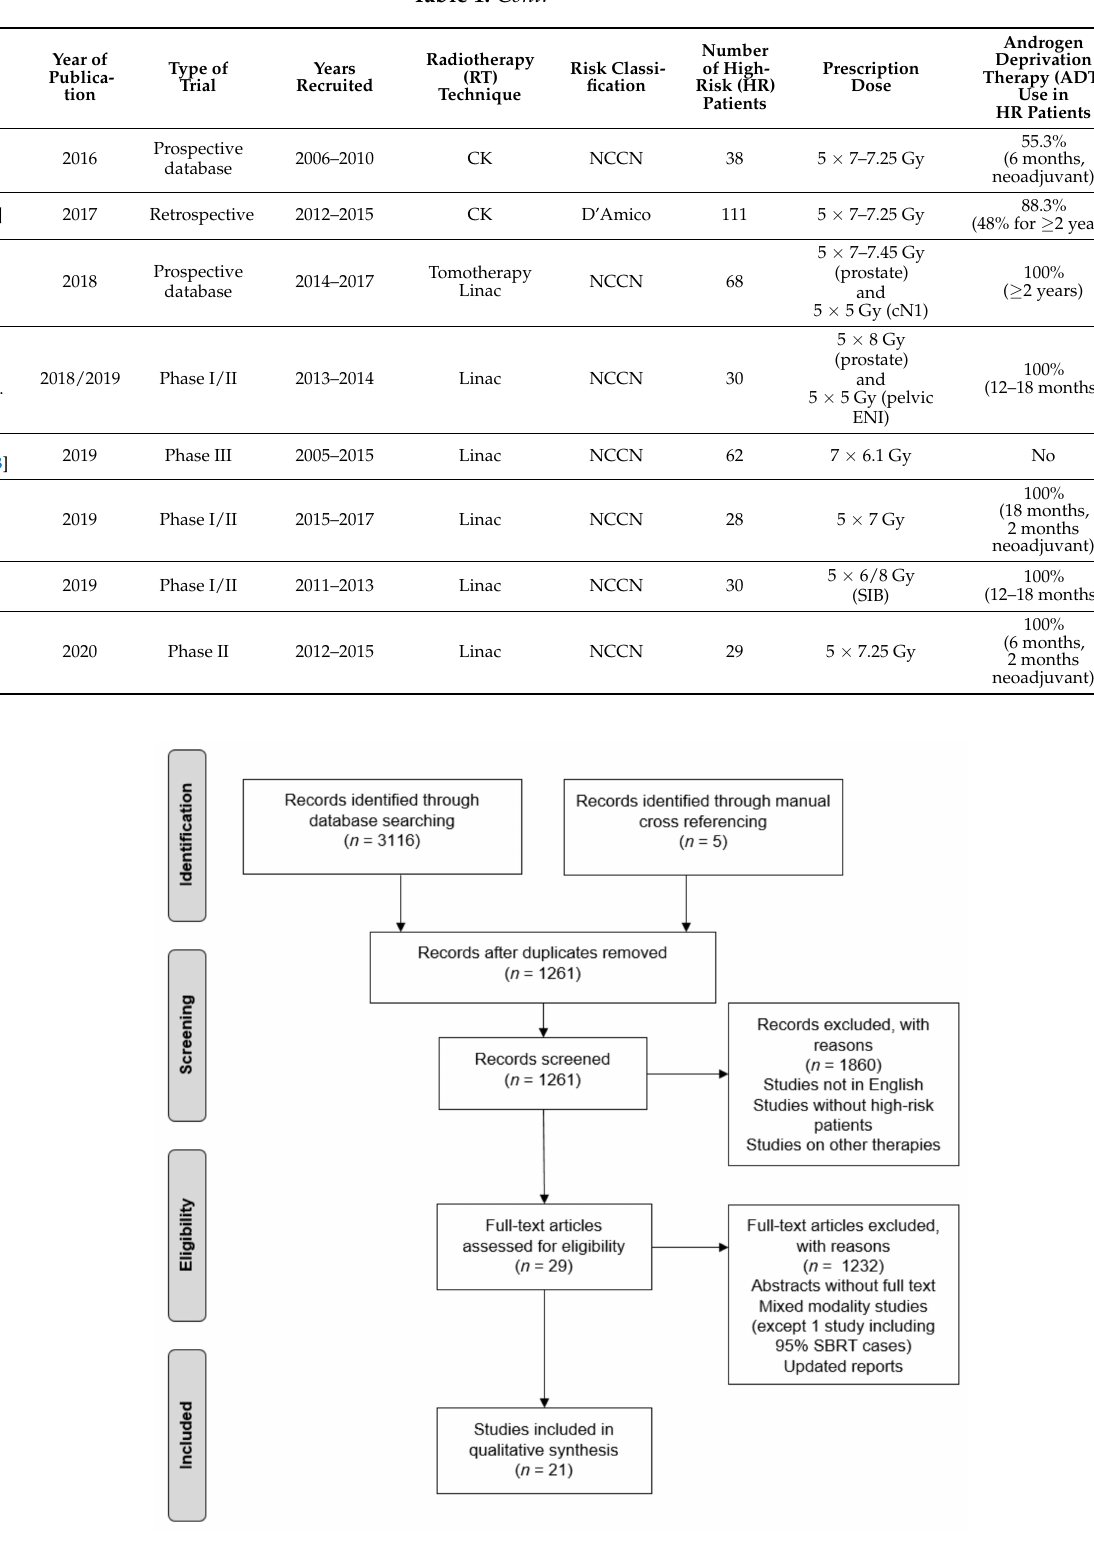
Figure 1. Consort diagram of the study selection